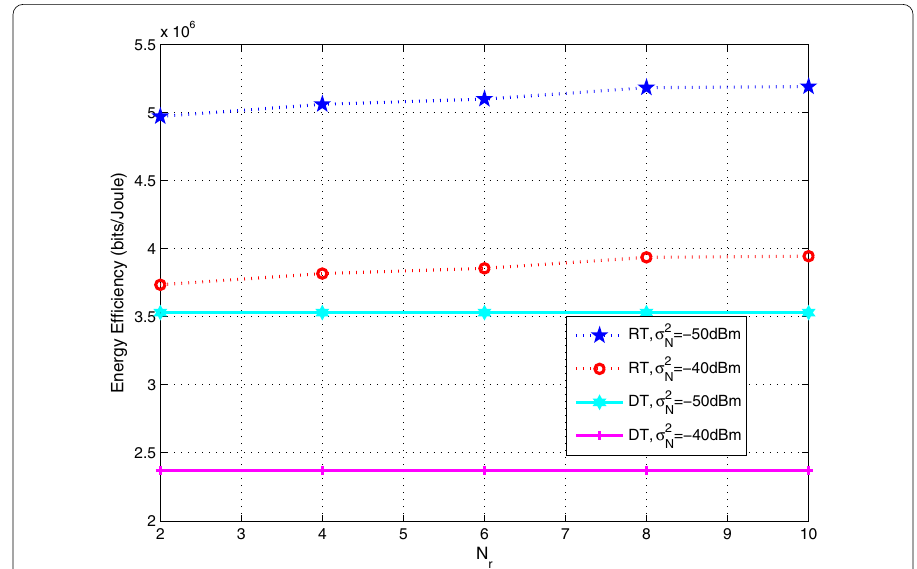
Fig. 5 Energy efficiency versus the number of relay nodes N r for σ 2 rj = − 50dBm, − 40dBm under RT and DT modes